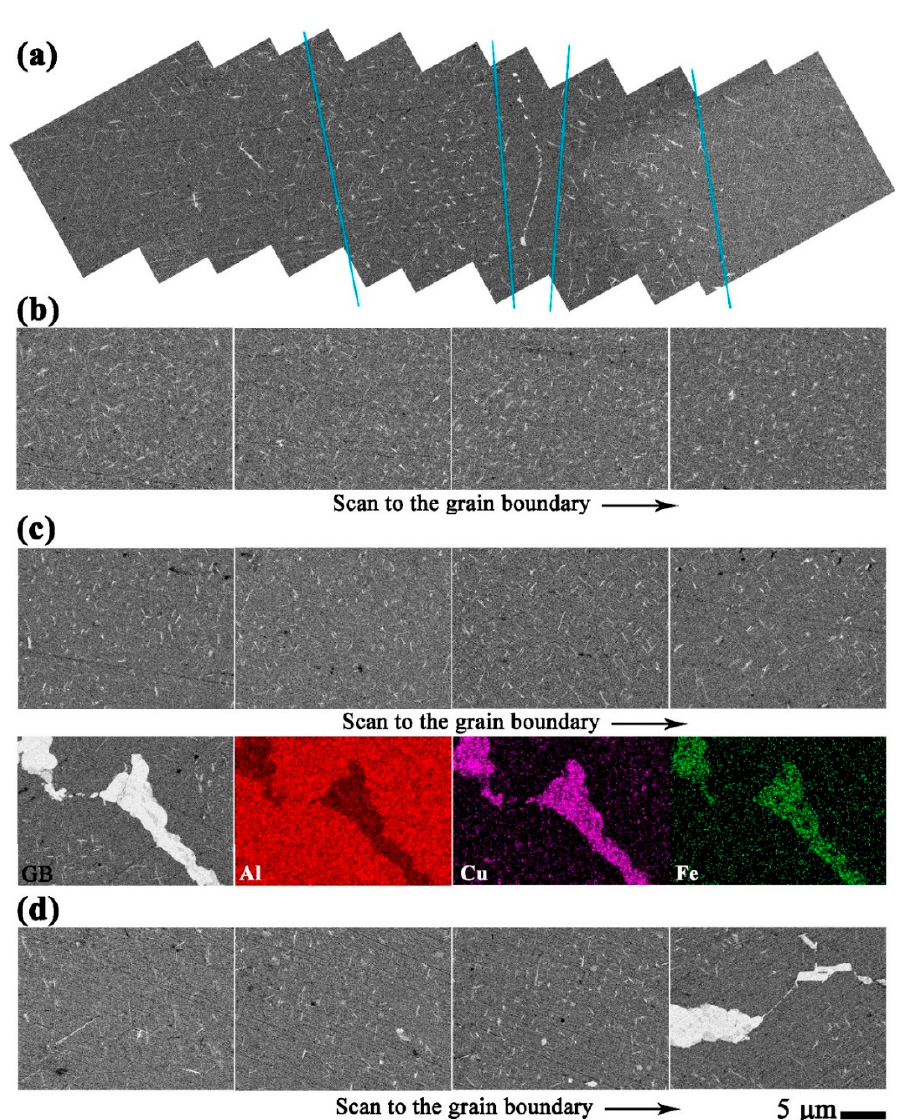
Figure 8. BSE images of the creep samples after 8 h: ( a ) 3#, ( b ) 6#, ( c ) 9#, and ( d ) 9A#.